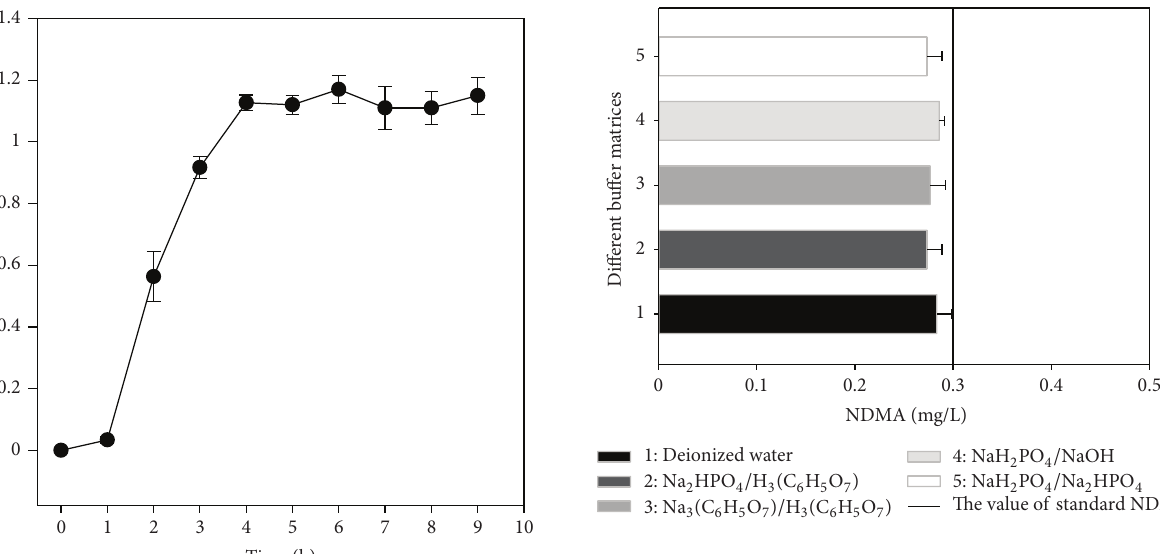
NaH PO /NaOH, and PO /Na HPO buffer solutions (pH = 6.4) for 4h. e NaH 4 horizontal bars represent the standard deviation ( 2 4 2 4 𝑛𝑛 𝑛 𝑛